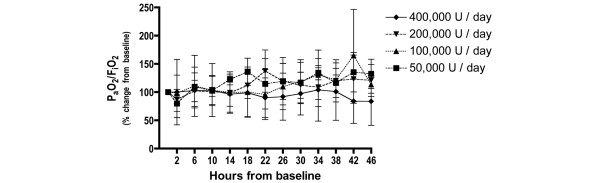
Changes in arterial to inspired oxygen ratio with nebulised heparin dosage. Percentage change from baseline in the arterial to inspired oxygen ratio (PaO2/FiO2) (mean ± standard deviation).